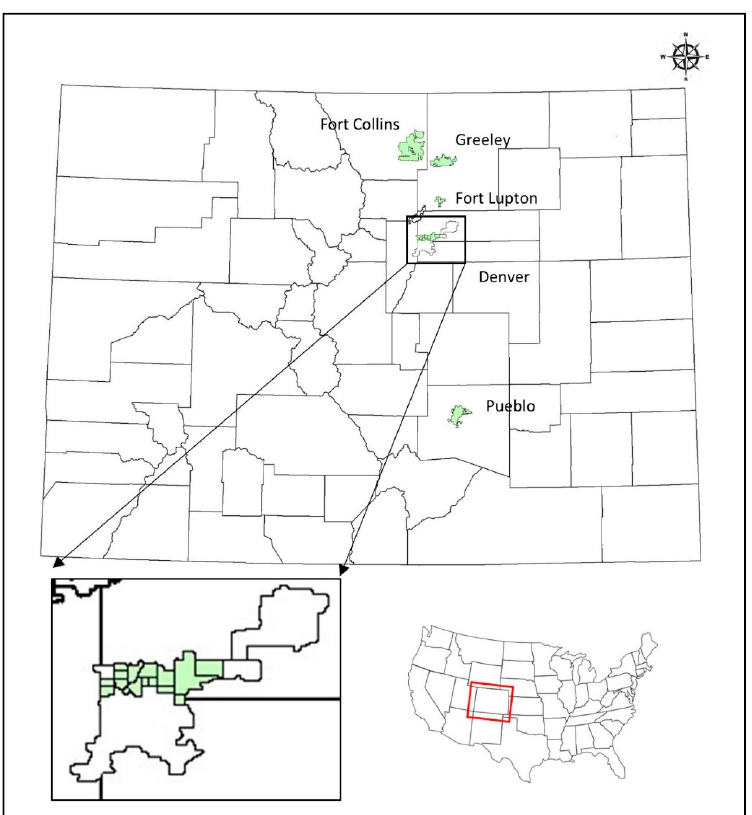
Figure 1. Locations of the five communities: Fort Collins in Larimer County, Greely and Fort Lupton in Weld County, North Denver in Denver County, and Pueblo in Pueblo County. Table 1. Demographic information of the five communities.